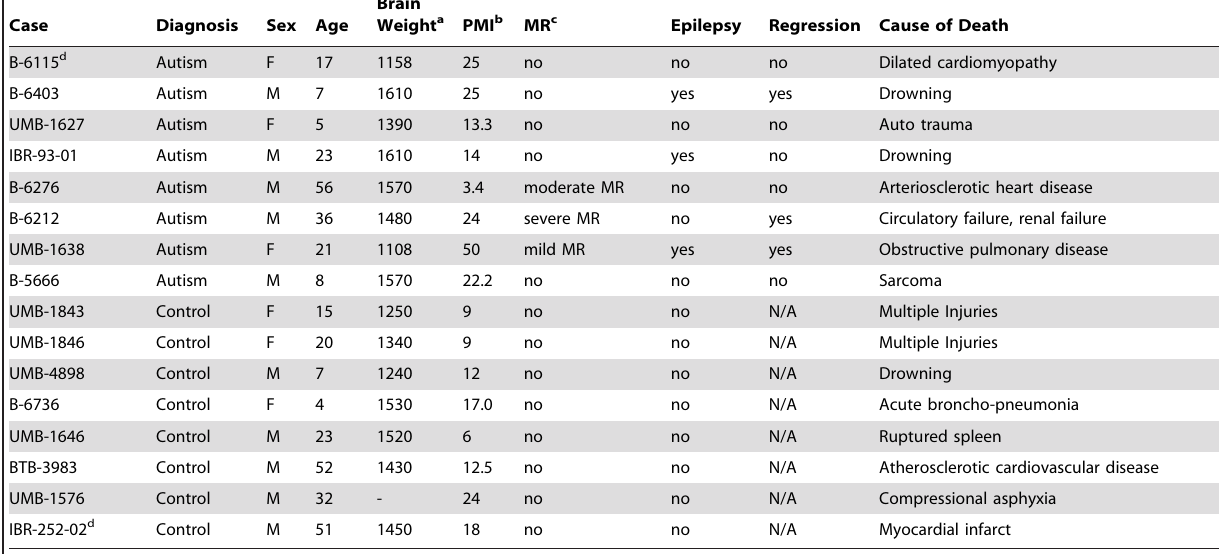
Table 1. Clinical